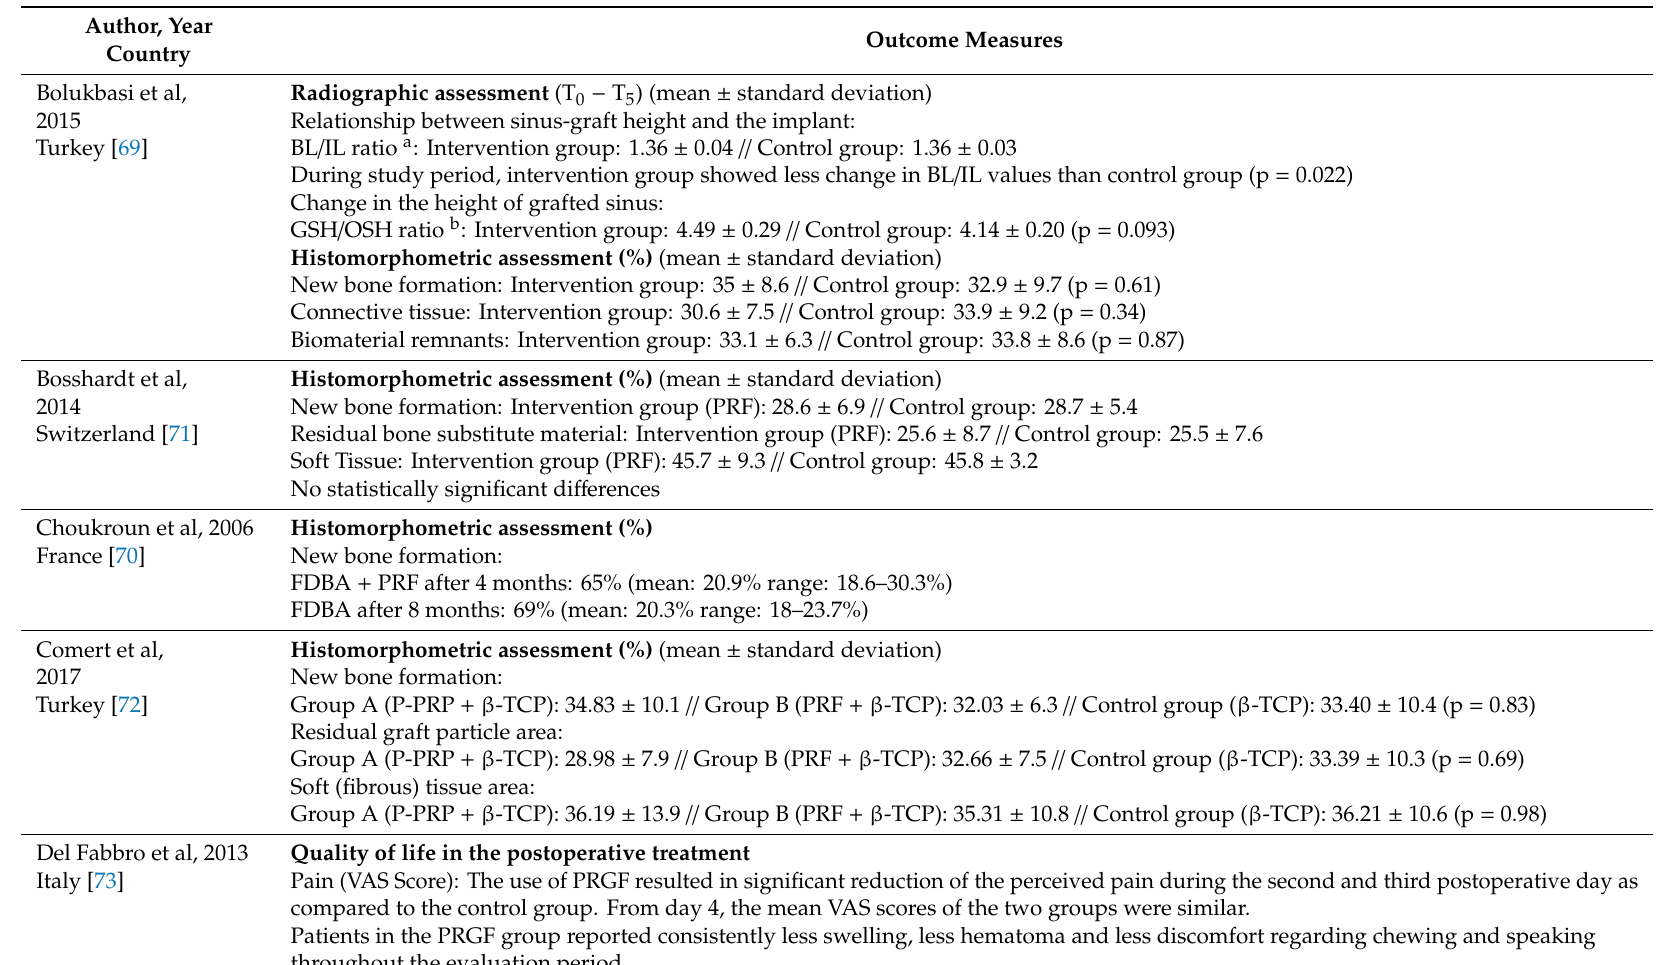
Table 4. Summary of outcome measures of studies reviews for PRF on sinus